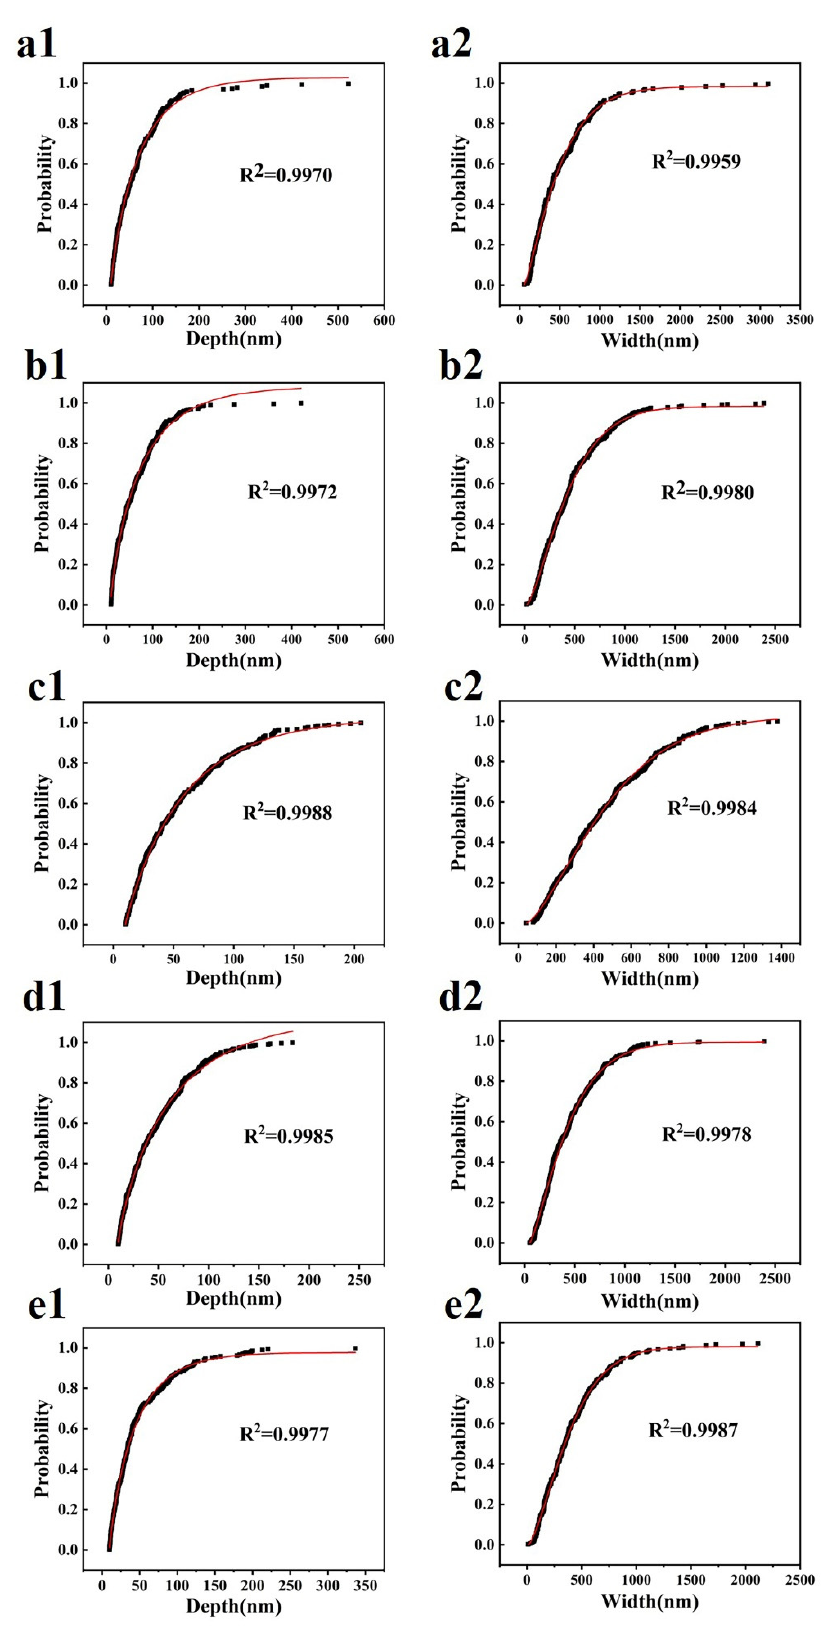
Figure 5. Weibull distribution fitting curve image of carbon fiber groove depth: ( a1 ) CF-1, ( b1 ) CF-2, ( c1 ) CF-3, ( d1 ) CF-4, ( e1 ) CF-5; Weibull distribution fitting curve image of carbon fiber groove depth: ( a2 ) CF-1, ( b2 ) CF-2, ( c2 ) CF-3, ( d2 ) CF-4, ( e2 ) CF-5.